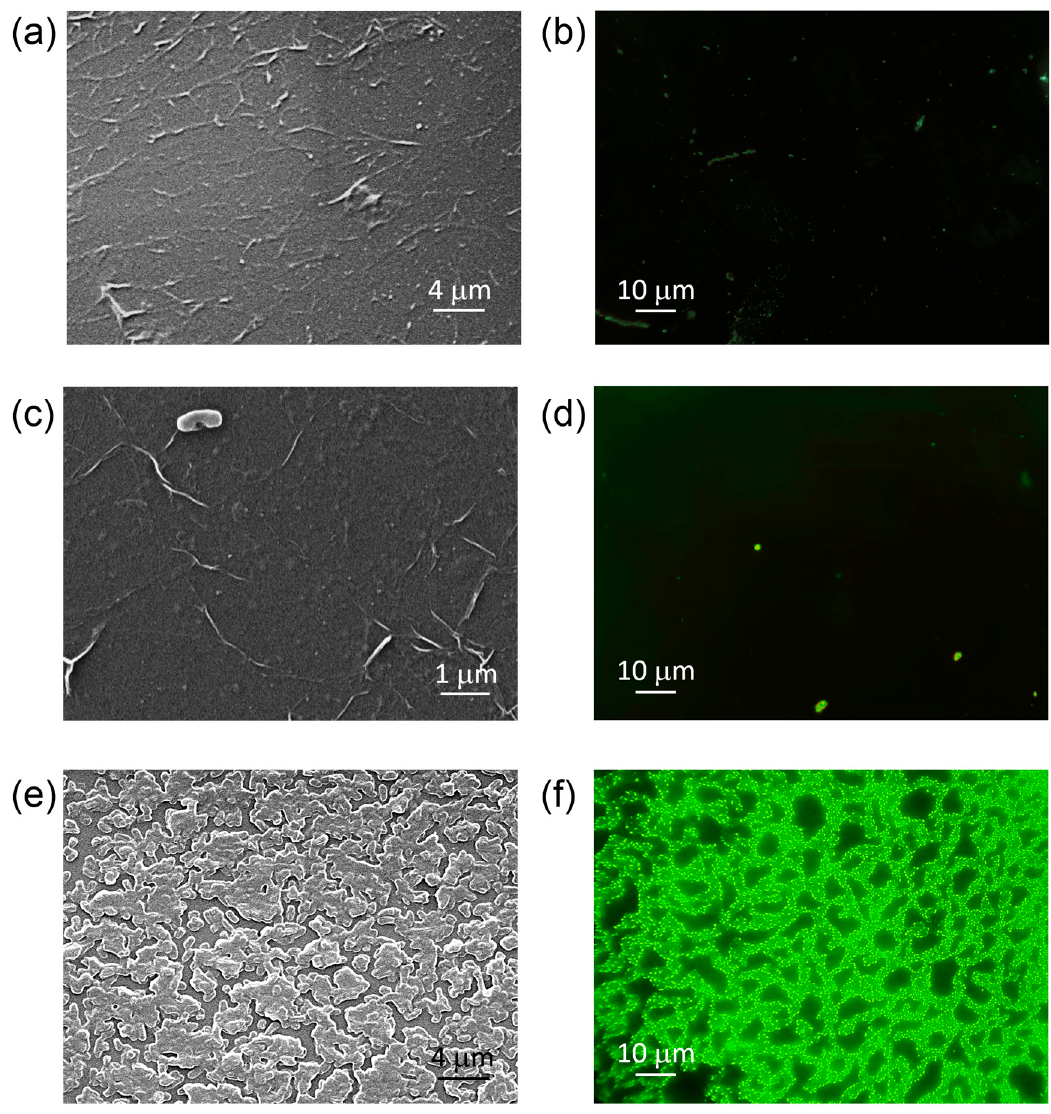
Figure 5. Scanning electron microscopy and epifluorescence images of Enterobacter cloacae biofilms’ distribution on coated and uncoated glass samples. SEM images of samples after E. cloacae 48 h incubation: ( a ) Graphene-coated glass, ( c ) h-BN-coated glass, and ( e ) uncoated glass. Corresponding epifluorescence microscopy micrographs for ( b ) graphene-coated glass, ( d ) h-BN-coated glass, and ( f ) uncoated glass.